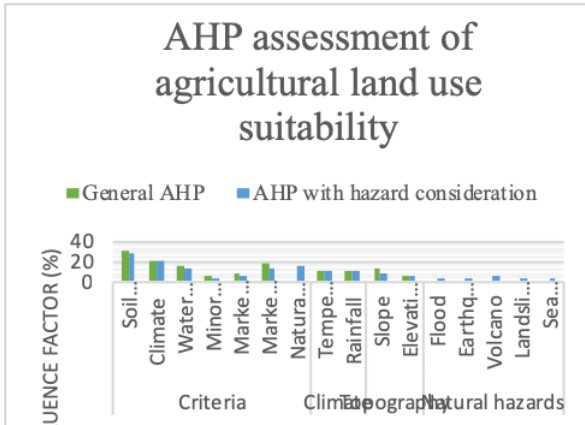
Figure 9. AHP weights of land-use suitability assessment for agricultural land-use